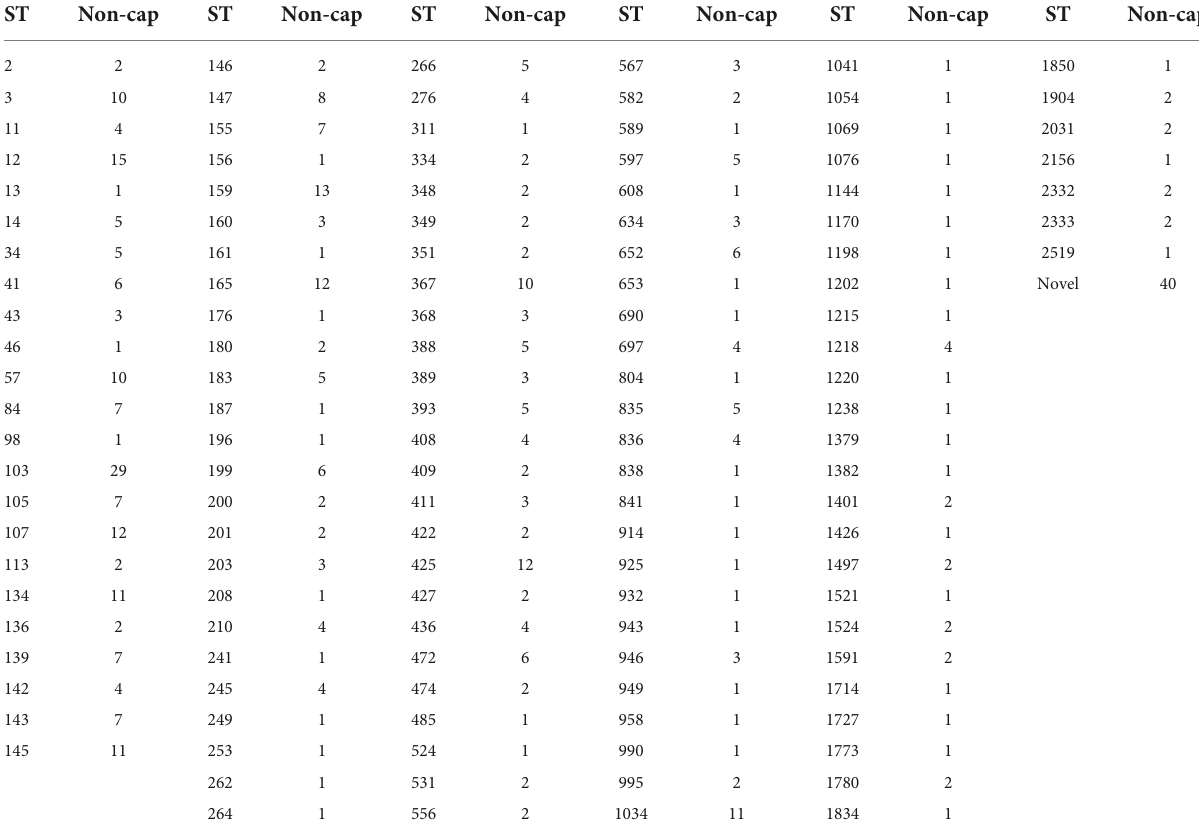
TABLE 5 Sequence types for Haemophilus influenzae non-cap